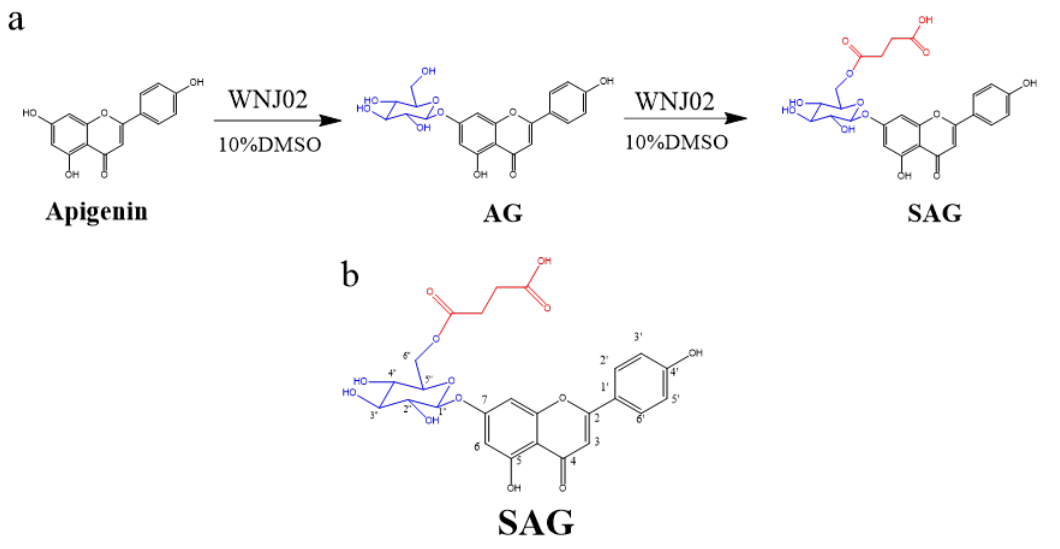
Figure 1. ( a ) Synthesis of apigenin-7- O - β -(6 (cid:48)(cid:48) - O )- D -glucoside (AG) and apigenin-7- O - β -(6 (cid:48)(cid:48) - O - succinyl)- D -glucoside (SAG), ( b ) The structure of SAG with